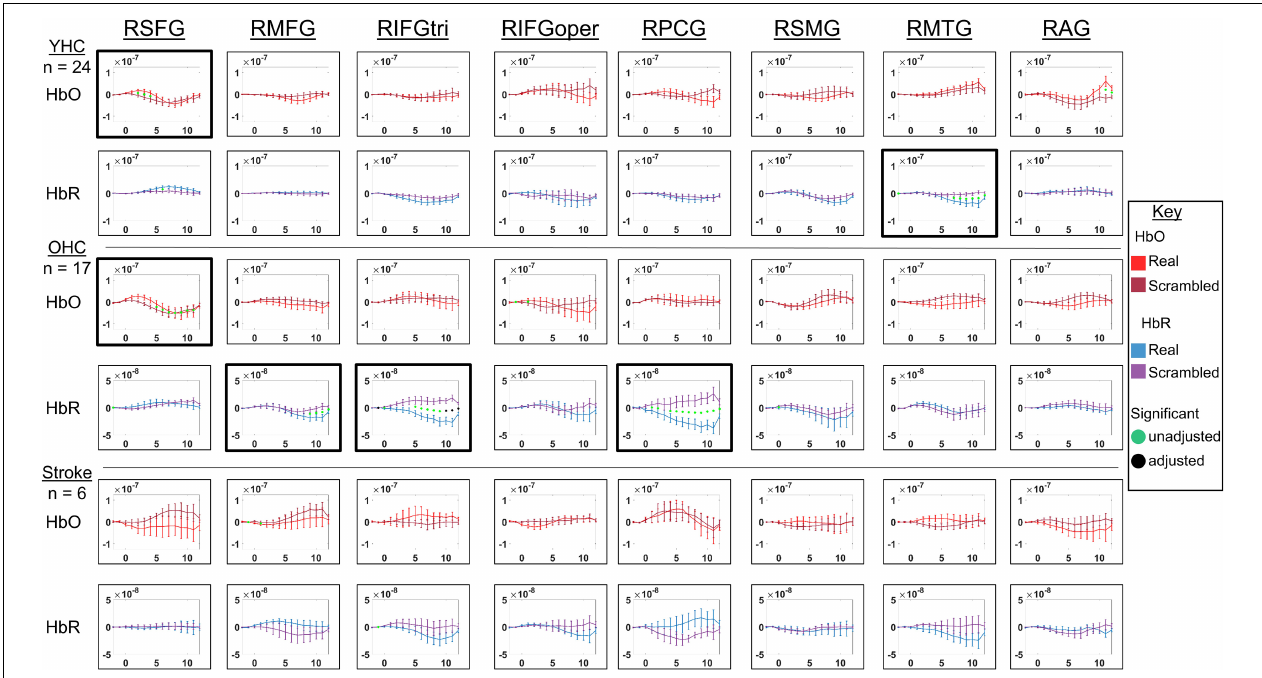
FIGURE 5 | Comparison of group average HRF between task conditions for right hemisphere ROIs during semantic feature judgment. HbO and HbR changes in µ M units. Significant difference between task conditions at p < 0.05 level are reflected by a green dot and after FDR-adjustment with alpha of 0.05 by a black dot. Black borders denote ROIs for which there was a significant difference between the task conditions for at least three consecutive seconds. When the red line is higher than the maroon line, it suggests there was greater HbO concentration change in the real than scrambled picture condition. When the blue line is lower than the purple line, it suggests there was lower HbR concentration change in the real than scrambled picture condition. Both patterns are consistent with greater neural activation (i.e., increase in oxygenated blood, decrease in deoxygenated blood) in the real than scrambled picture condition and vice versa. RSFG, right superior frontal gyrus; RMFG, right middle frontal gyrus; RIFGtri, right inferior frontal gyrus pars triangularis; RIFGoper, right inferior frontal gyrus pars opercularis; RPCG, right precentral gyrus; RSMG, right supramarginal gyrus; RAG, right angular gyrus; YHC, younger healthy controls; OHC, older healthy controls; HbO, oxygenated hemoglobin concentration change; HbR, deoxygenated hemoglobin concentration